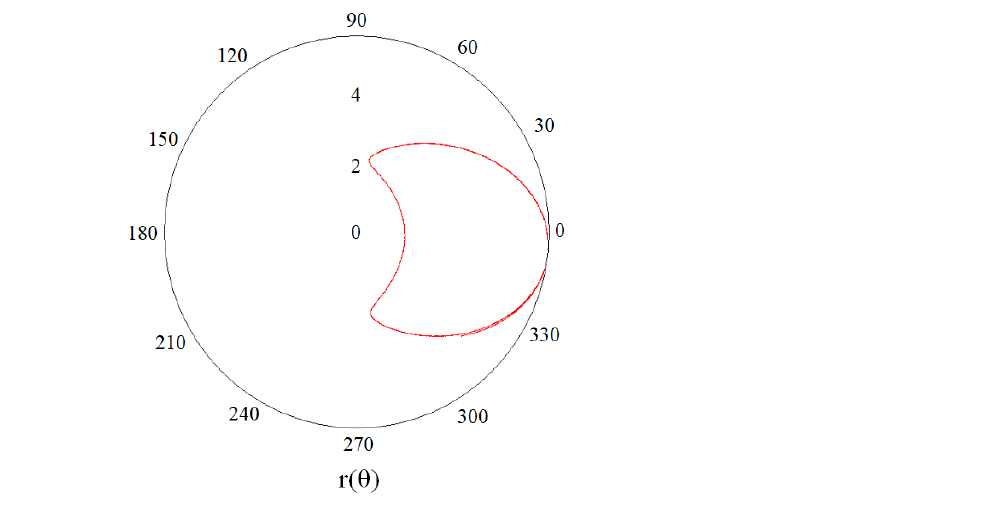
Figure 1. Polar plot of all heliocentric distances and heliolatitudes covered by the Ulysses pass from 1994 to 2009. Distances in the plane (R, θ ) are indicated in AU.